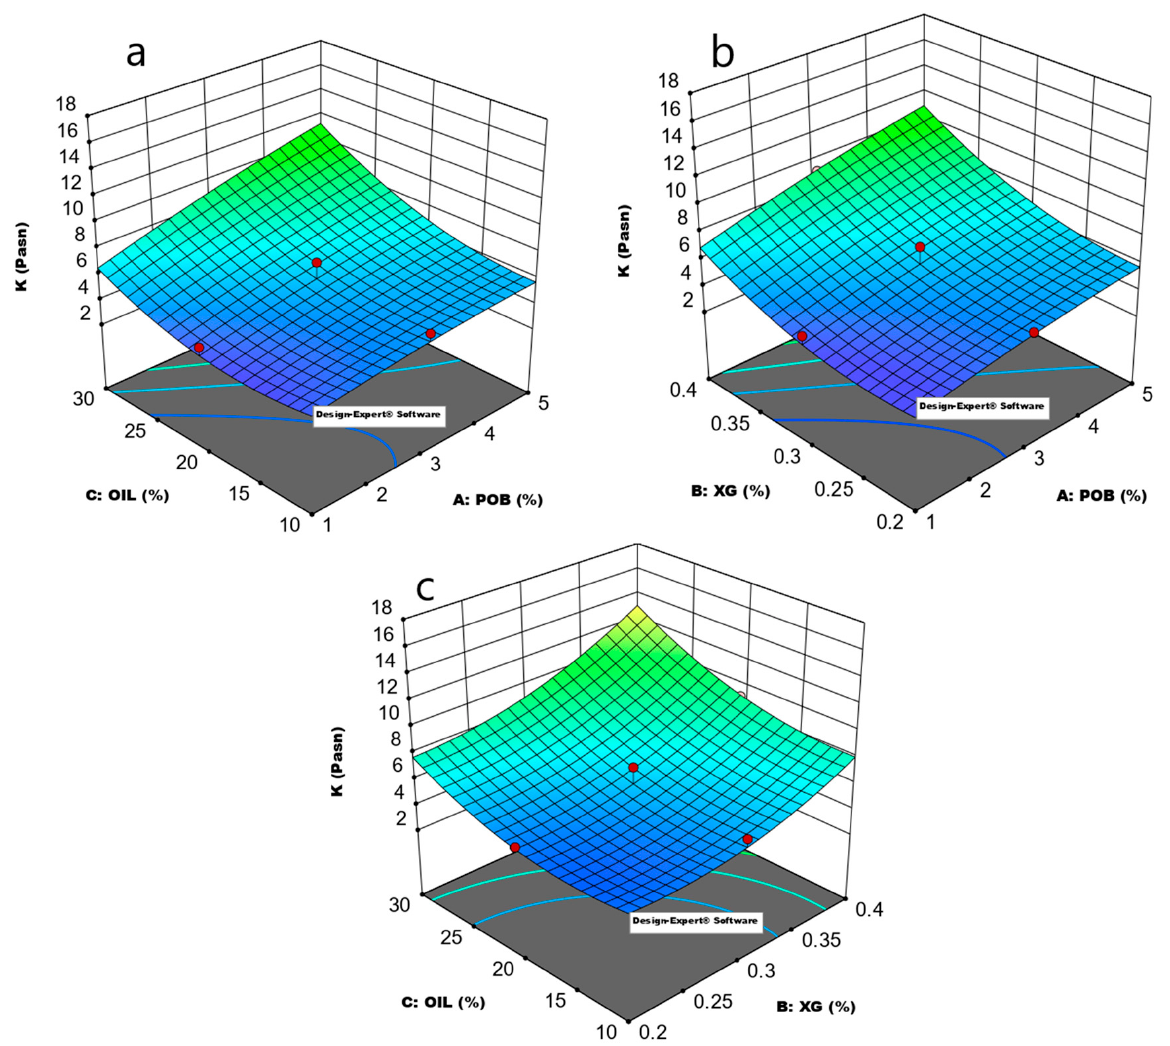
Figure 4. Response surface plot showing the effect of model parameters on the K value of salad dressing. ( a ): POB-Oil, ( b ): XG-POB, ( c ): XG-Oil (A: XG (xanthan gum), B: POB (pumpkin seed oil by-product), C: fat (milk fat), K: consistency coefficient).